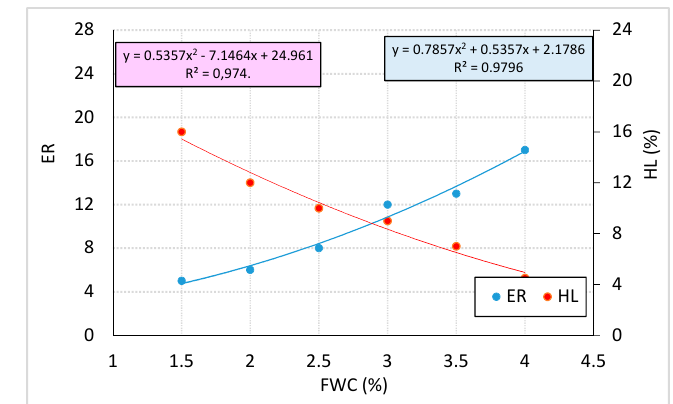
Figure 5. Foamed 50/70 bitumen characteristics. Figure 5. Foamed 50 / 70 bitumen characteristics.